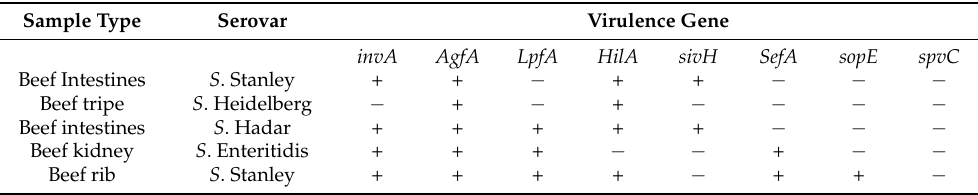
Table 4. PCR results for eight virulence genes from six Salmonella isolates obtained from beef